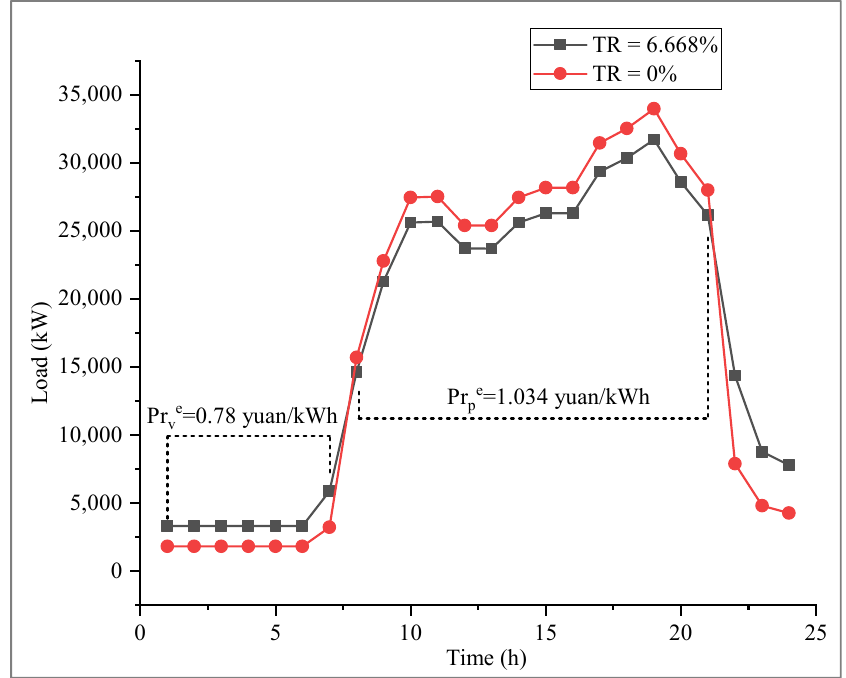
Figure 14. Shifted load of point A compared with original load.